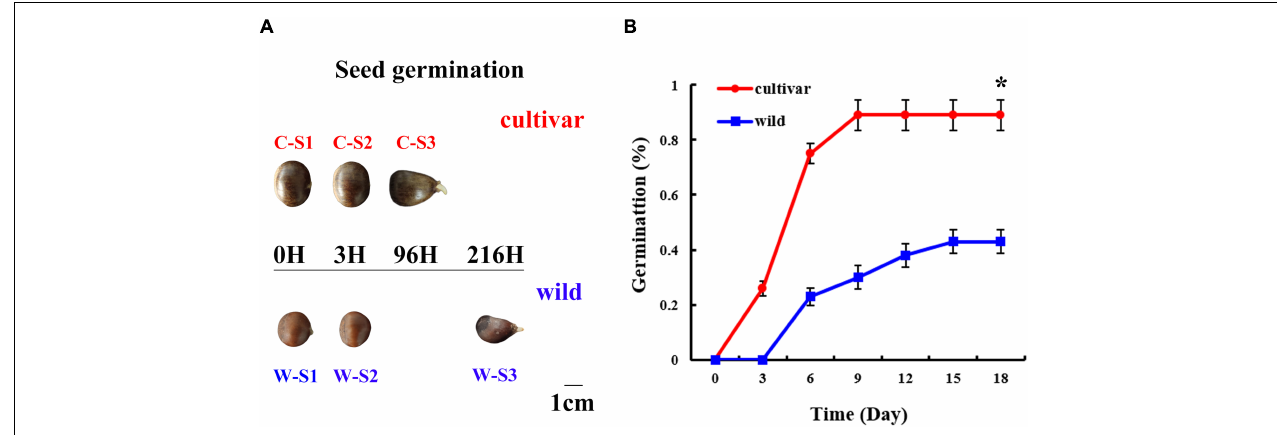
FIGURE 1 | Morphology and physiology of the seed germination process at different developmental stages in wild and cultivated Chinese chestnut. (A) Morphology of wild and cultivated Chinese chestnut seeds at different developmental stages of germination. S1: seed embryos after imbibition for 0 h; S2: seed embryos after imbibition for 3 h; S3: radicle emergence at 96 h for cultivated seeds and 216 h for wild seeds. (B) The seed germination rate of Chinese chestnut. * indicates a significant difference at P <